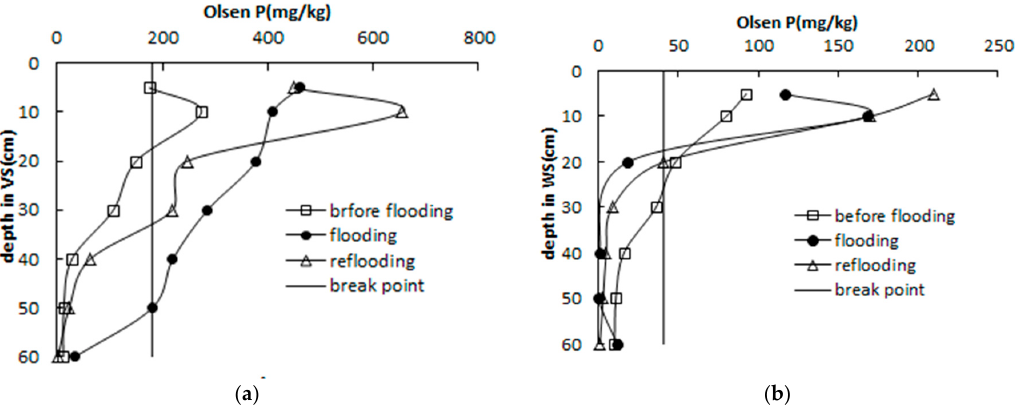
Figure 6. Changes in Olsen P before and after flooding and reflooding (( a ) Olsen P in VS; ( b ) Olsen P in WS).